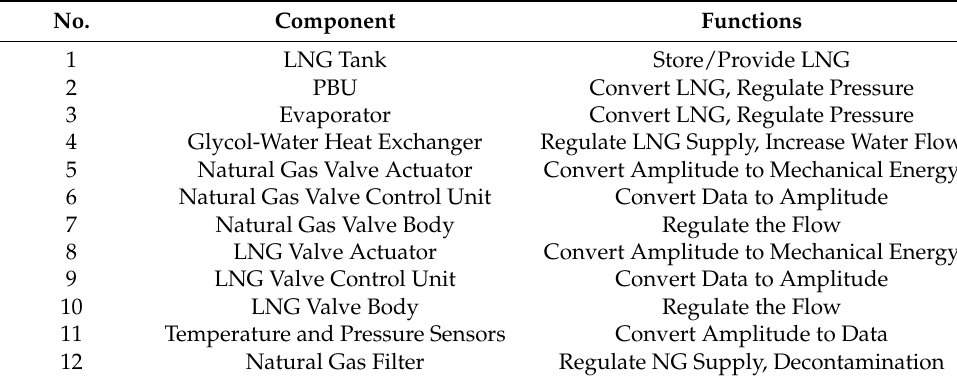
Table 5. Component functionality in the